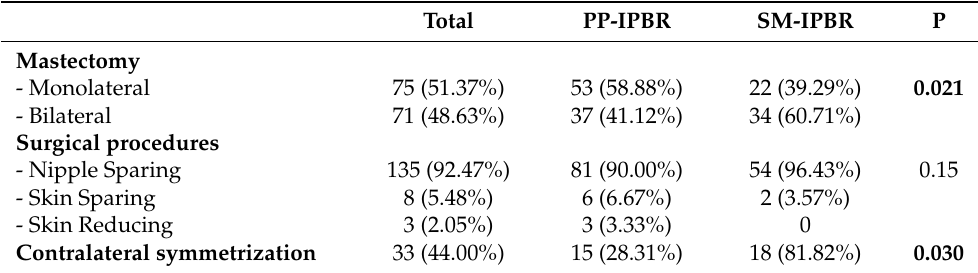
Table 2. Detailed surgical treatment.